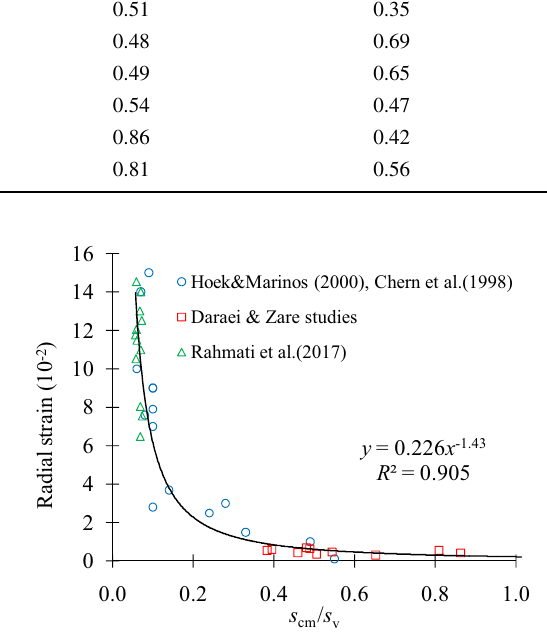
Fig. 15 Relationship of the radial strain with strength